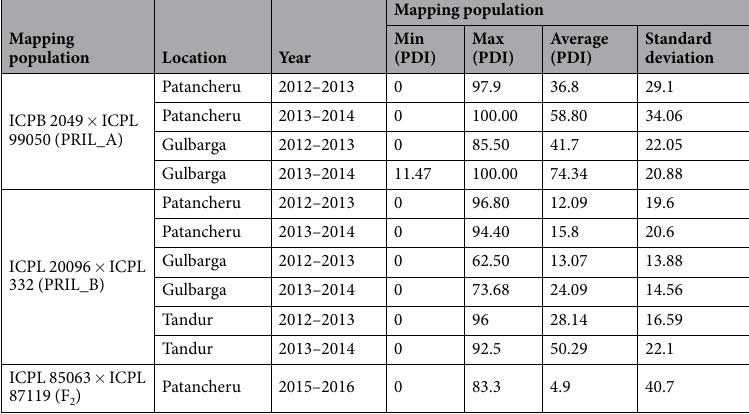
Table 1. Phenotypic variation of the FW resistance in pigeonpea recombinant inbred lines (PRILs) and F 2:3 families. PDI: Percent Disease Incidence score after 90 days of